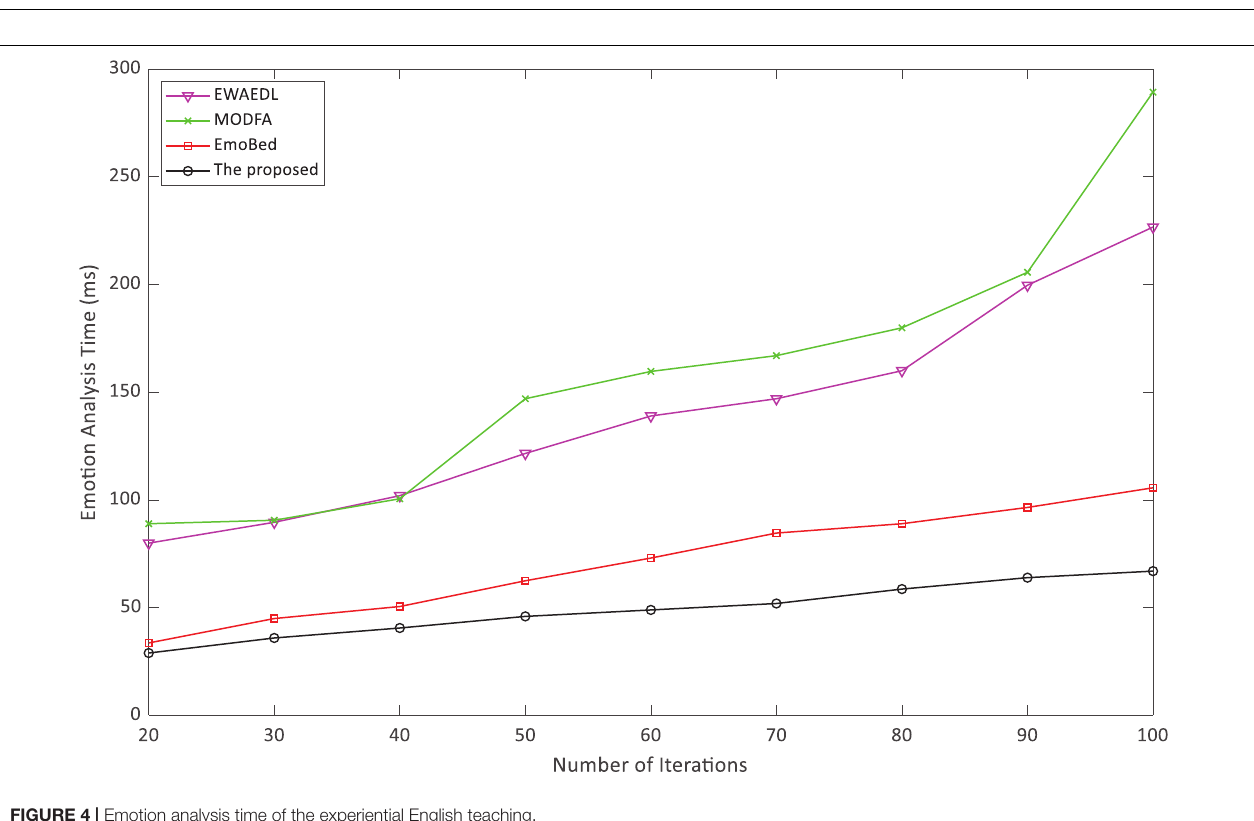
FIGURE 3 | Accuracy of the experiential English-teaching emotion analysis.